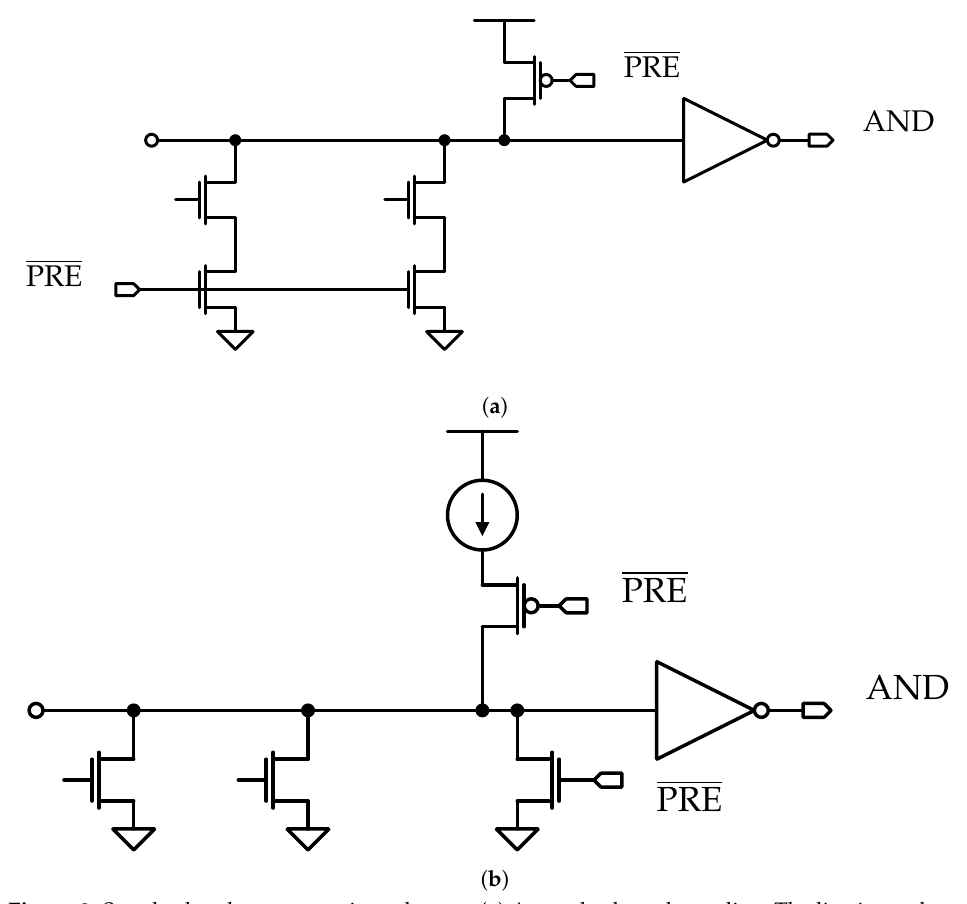
Figure 9. Standard and current-saving schemes. ( a ) A standard precharge line. The line is precharged to the logic ‘1’ using a pull-up transistor, while all the pull-downs are disabled using footer transistors; then, these are enabled by deactivating PRE during the evaluation phase. ( b ) The current-saving line. In this scheme, footer transistors are not needed for disabling the pull-downs, since the line is pre-discharged instead of being pre-charged; then, during the evaluation phase, the line gets charged if there are not conducting